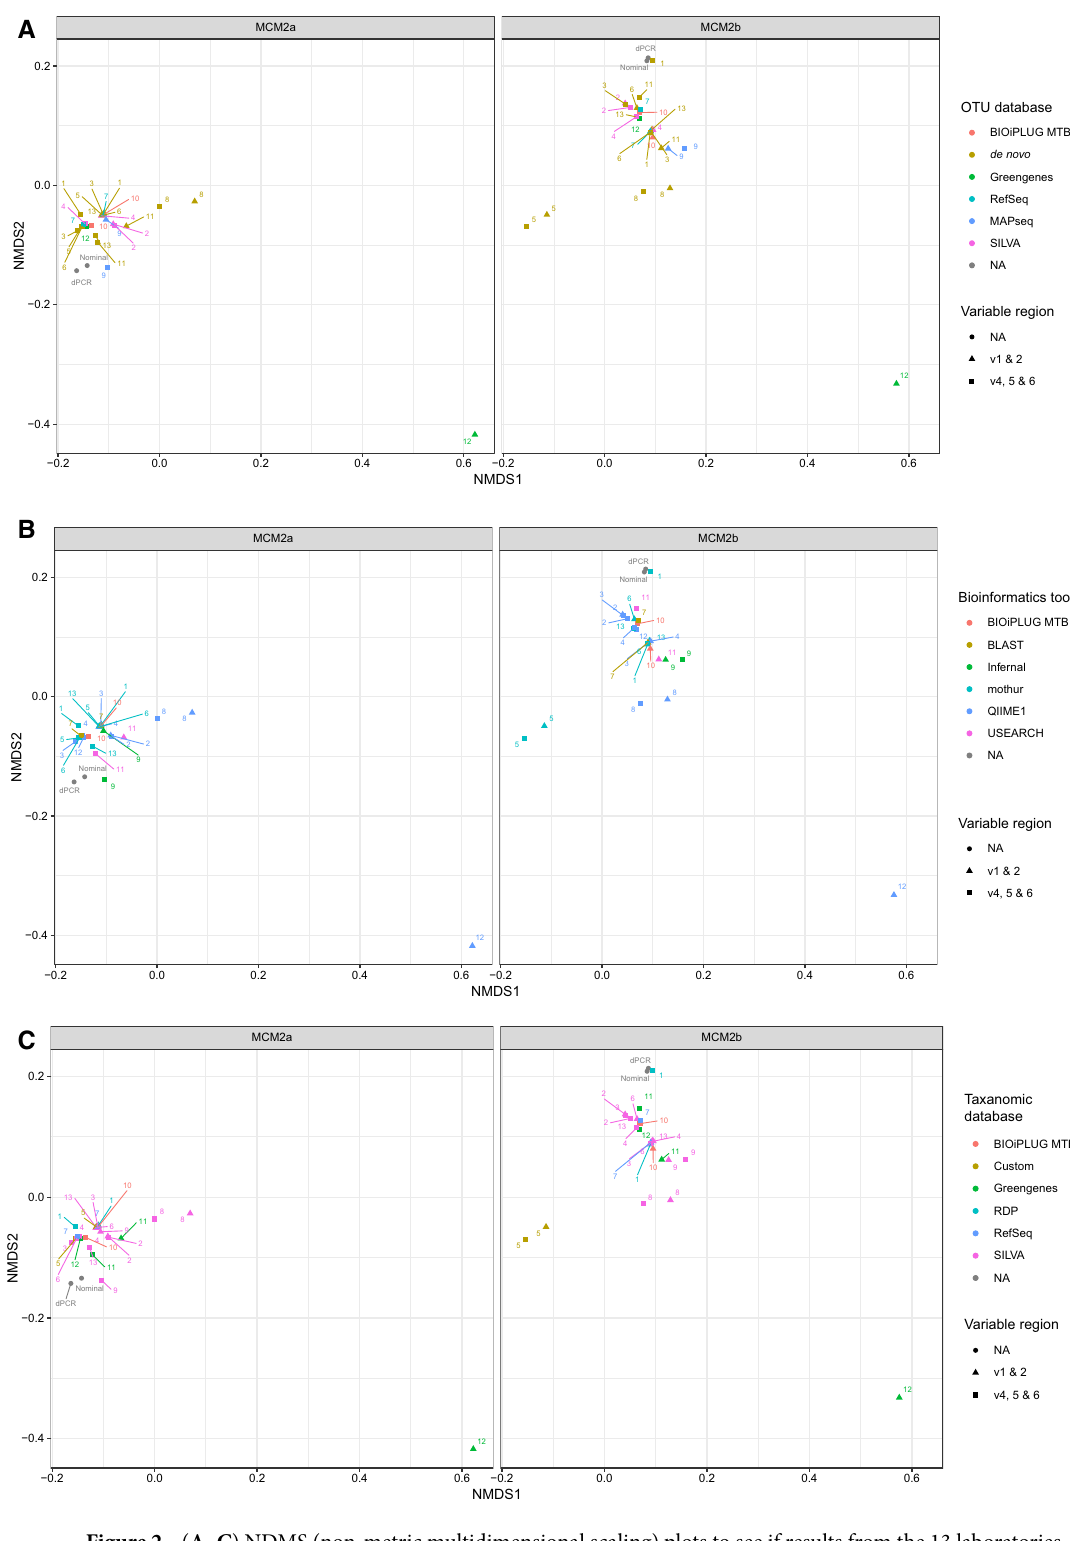
Figure 2. ( A – C ) NDMS (non-metric multidimensional scaling) plots to see if results from the 13 laboratories cluster according to OTU assignment tool ( A ), OTU assignment database ( B ) and taxa assignment database ( C ). OTU assignment database was included for laboratories that used closed reference OTU picking. They generally compared their sequences against a reference database of sequences that clustered the reads into OTUs based on sequence similarity. Later, many laboratories assigned taxonomic identifiers to each of these OTUs using a separate database which had sequence data (sometimes not clustered into OTUs) and which taxa that sequence originated